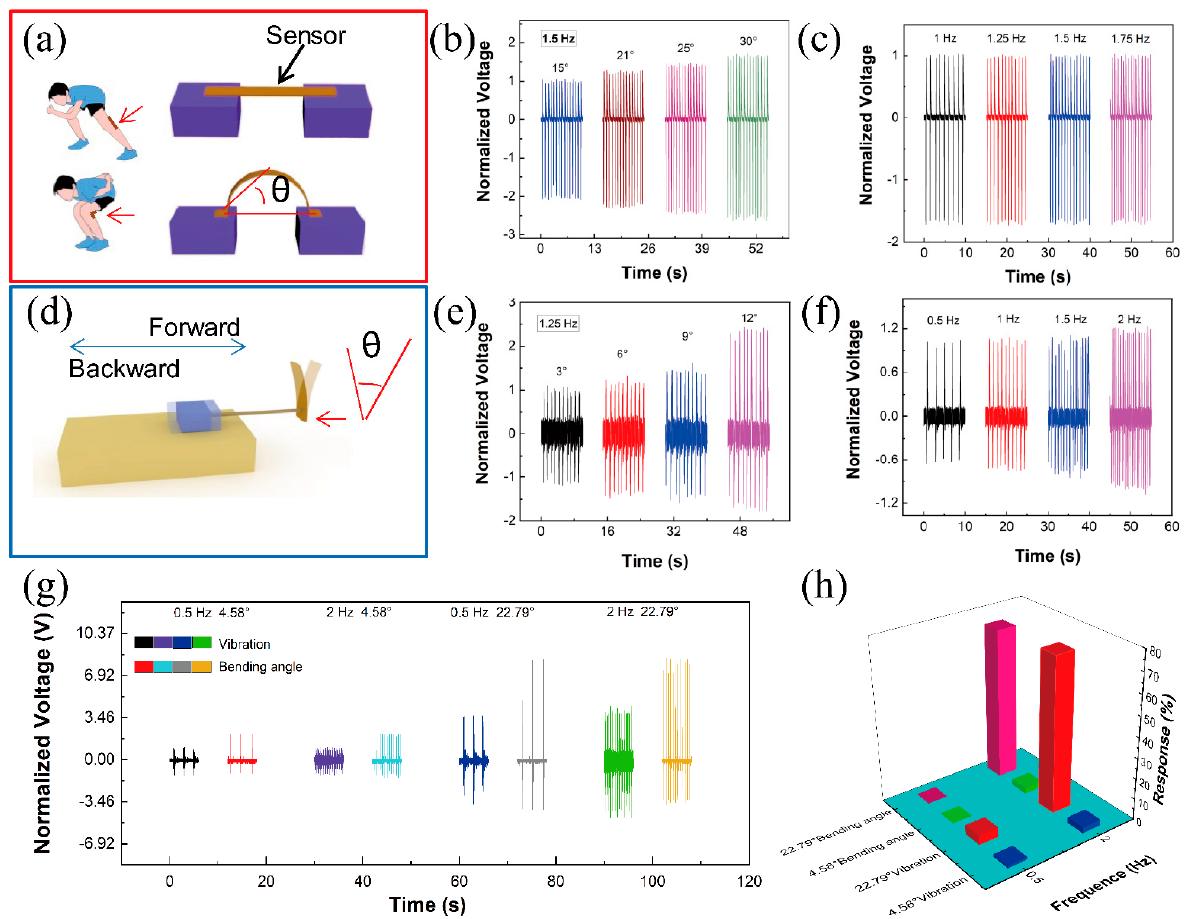
Figure 3. The sensing performance testing of the sensor; ( a ) the measurement system for mimicking the motion of the knee-joint; ( b ) the relationship between the output voltage and bending angles (the red line showing the fitting line); ( c ) the normalized output piezoelectric voltage against different frequencies at the same bending angles (15 ◦ ); ( d ) the measurement system for mimicking the vibration on the skate blade; ( e ) the relationship between the output voltage and bending vibration (the red line showing the fitting line); ( f ) the normalized voltage against different skating frequencies at the same skating stride (3 ◦ ); ( g ) the signals from two sensors (one attached to the knee-joint and another attached to the ice skate blade) for four motion states (small skating stride with low skating frequency, small skating stride with high skating frequency, big skating stride with low skating frequency and big skating stride with high skating frequency); ( h ) the relationship between motion state and the response of the